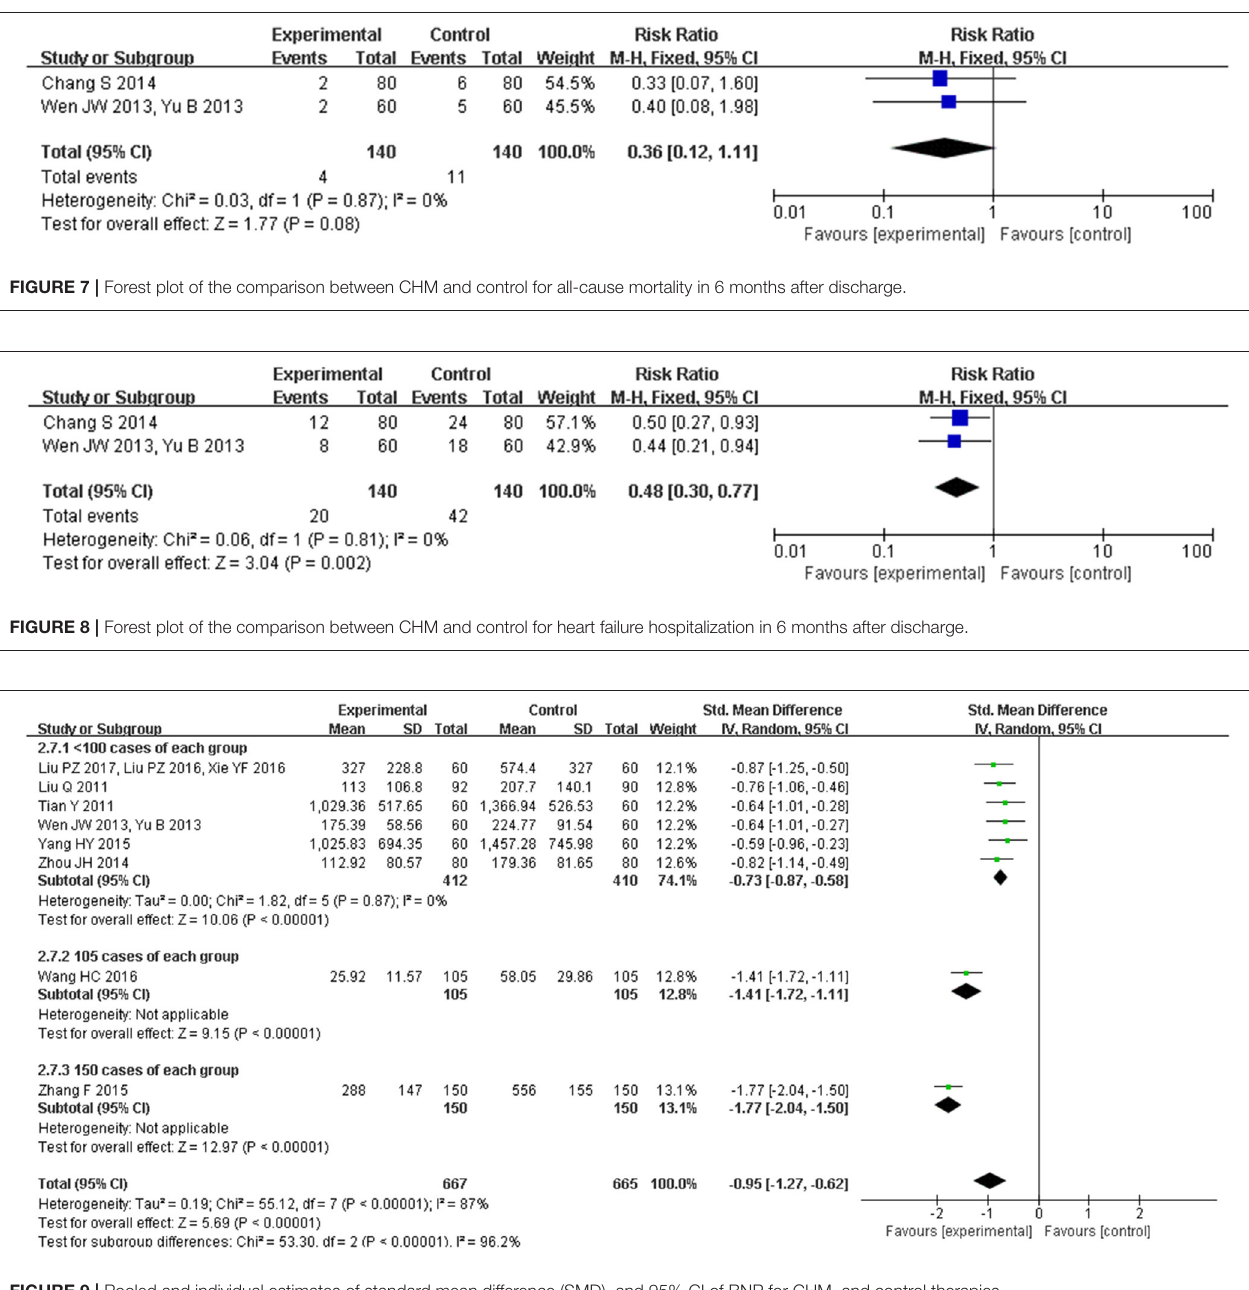
compounds of semen lepidii with 100 targets, and 150